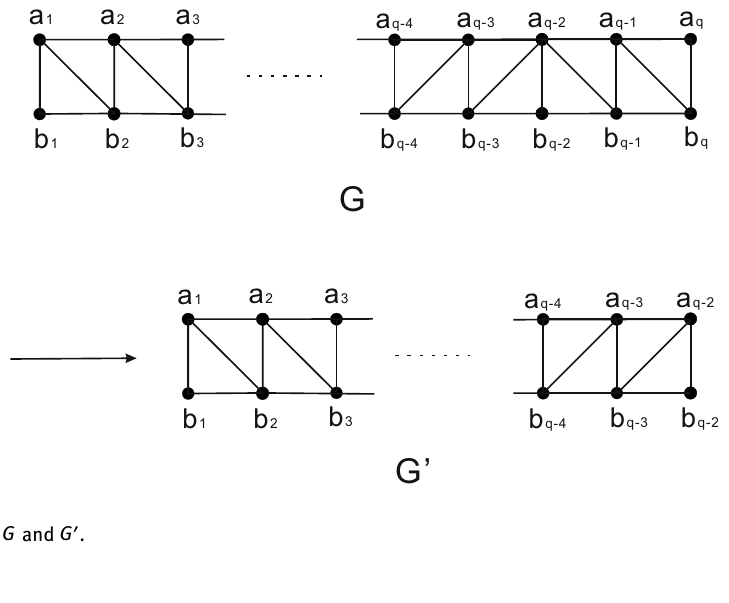
Figure 4: The graphs G and G ′